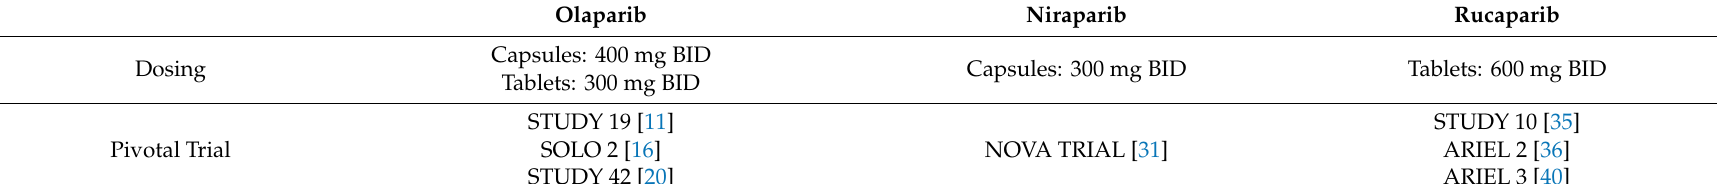
Table 6. United States (US) Food and Drug Administration-European Medicines Agency (FDA-EMA) approved indications for poly (ADP-ribose) polymerase (PARP) inhibitors and relevant adverse events